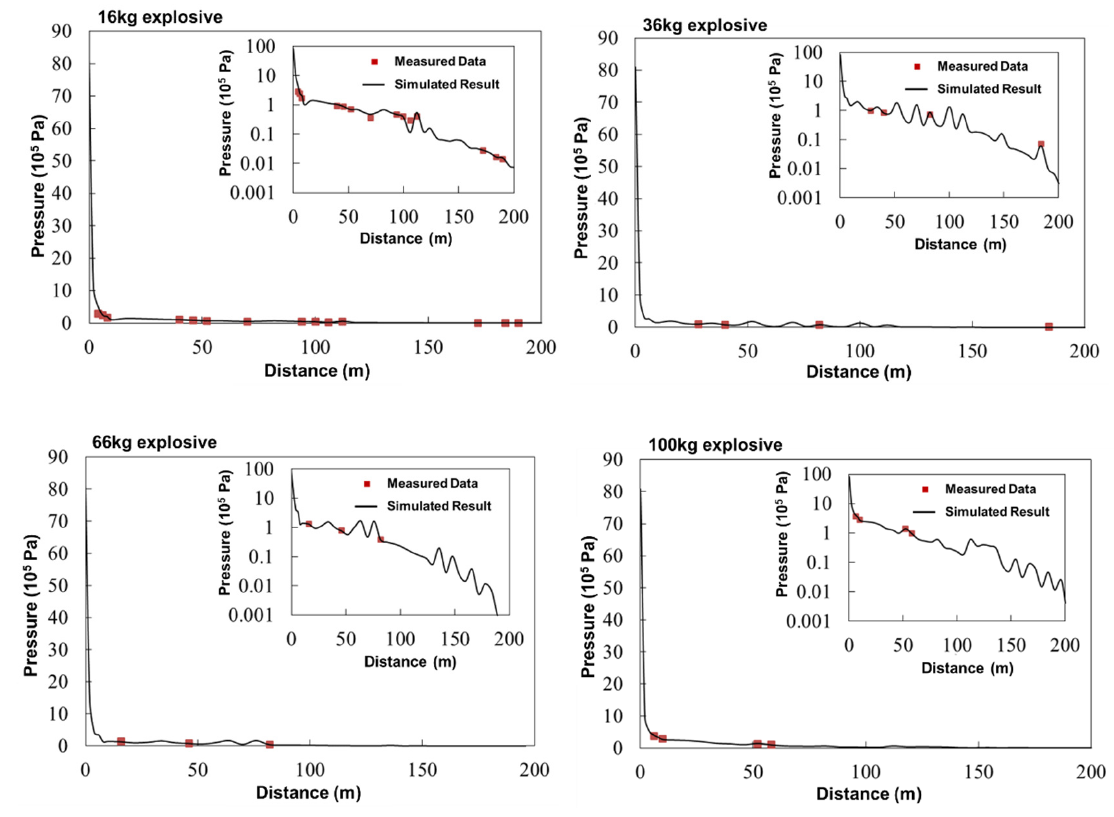
Figure 6. Diagram of shock wave pressure transmission.